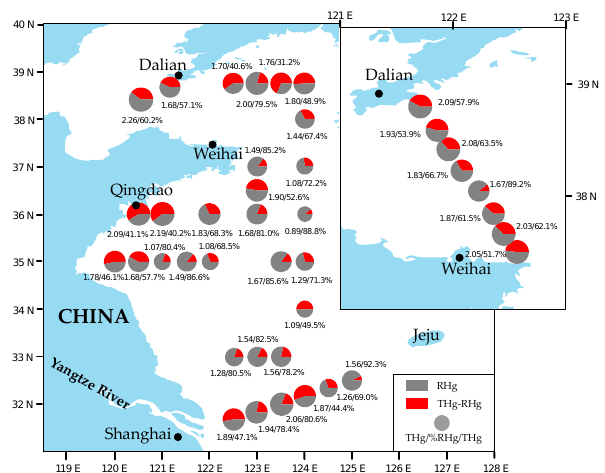
Fig. 4. Spatial distribution of DGM (unit in pgl − 1 ) in the surface waters of the Yellow Sea during the cruise in July 2010. Figure 4. Spatial distribution of DGM (unit in pg l -1 ) in the surface waters of the Yellow Sea during the cruise in July 2010.